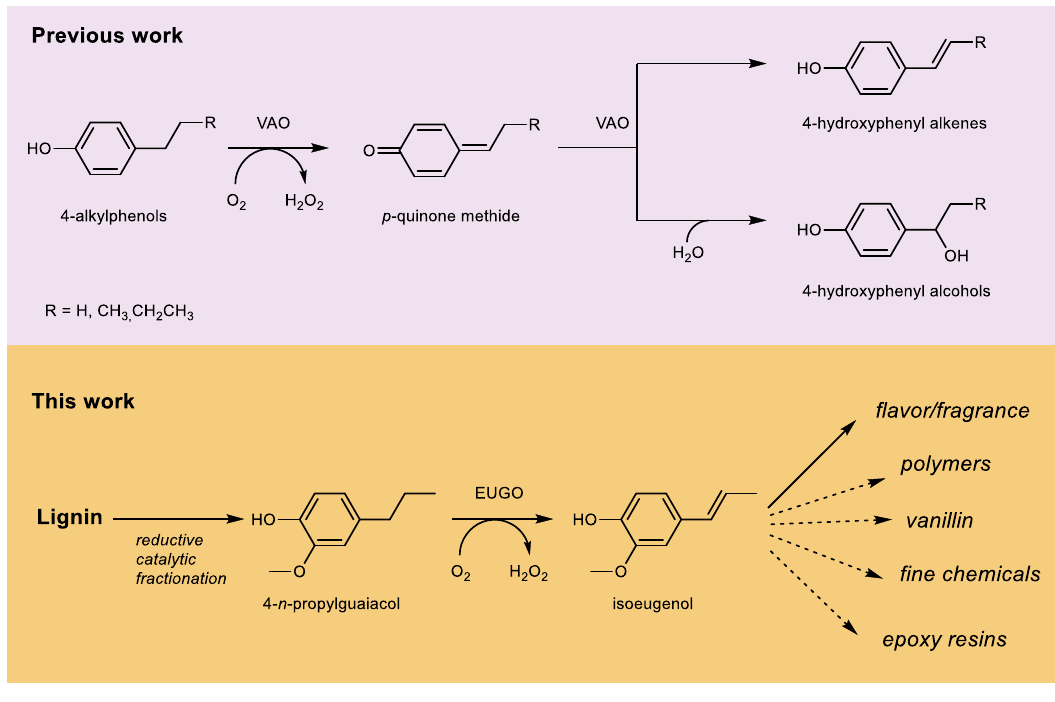
high-value products. The upper panel shows the mechanism by which VAO oxi- dizes 4-alkylphenols. The lower panel shows the catalytic pathway, which includes an engineered EUGO, by which lignin can be converted into valuable